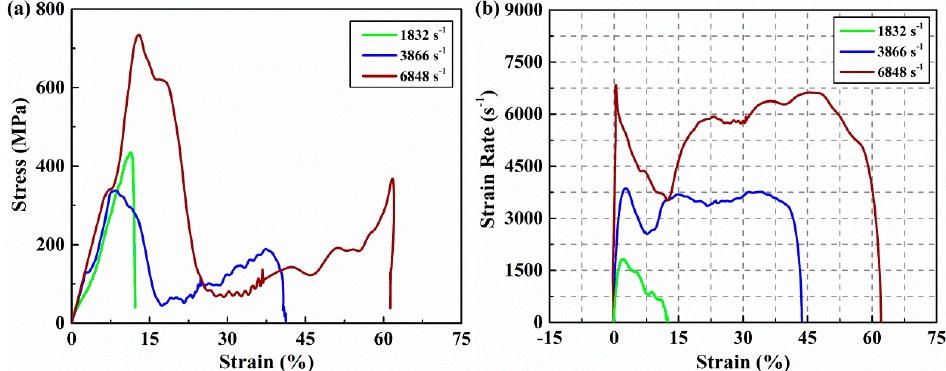
Figure 5. Stress and strain rate as a function of strain at strain rates of 1832, 3866, and 6848/s during the test. ( a ) Stress versus strain. ( b ) Strain rate versus strain.